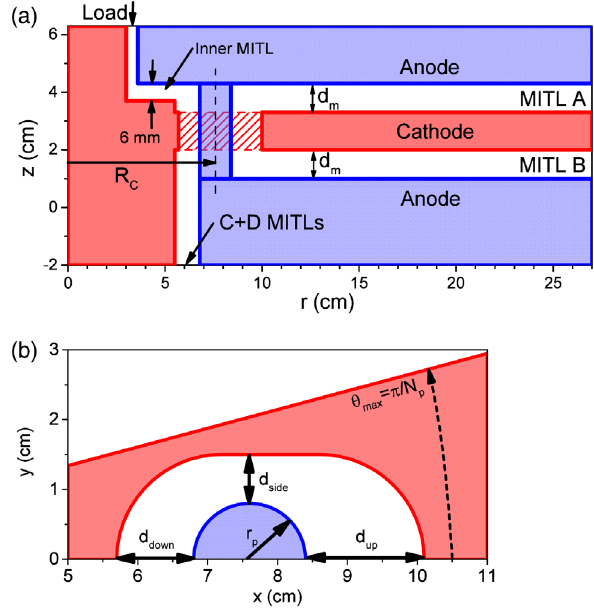
FIG. 1. Schematics of the simulation geometry. In (a) the simulation setup is shown in the θ ¼ 0 plane that bisects the anode post, and in (b) a cross section of the cathode hole and anode post are shown. Key design parameter variables are